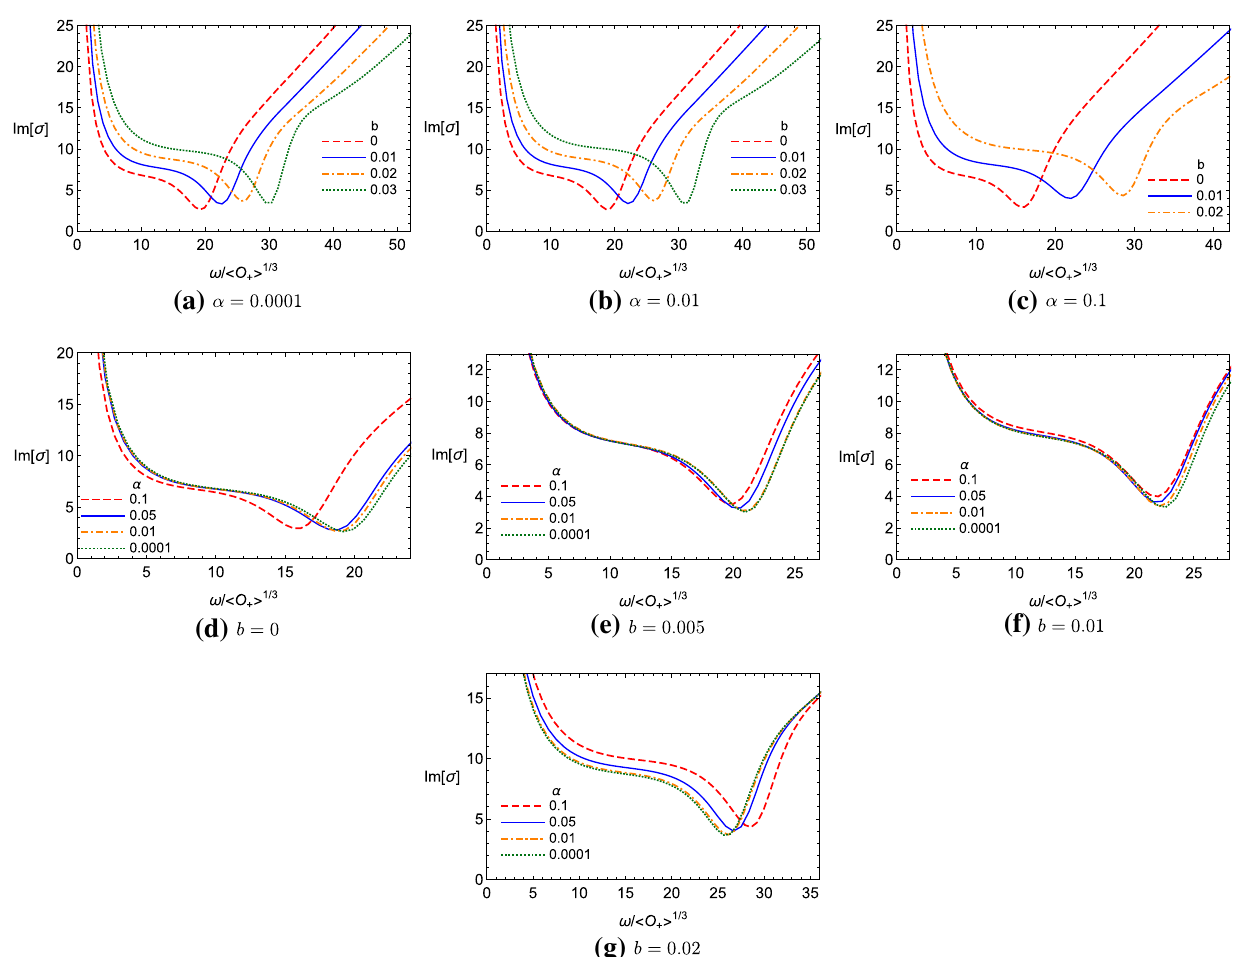
Fig. 7 The imaginary part of the conductivity as a function of ω/ < O + > 1 / 3 , at low temperatures, around T ≈ 0 . 1 T c